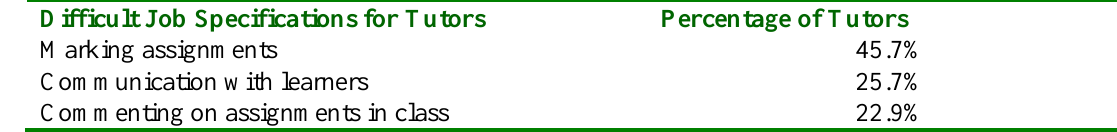
Table 16. Difficult job specifications for tutors (tutors’ perspective) Difficult Job Specifications for